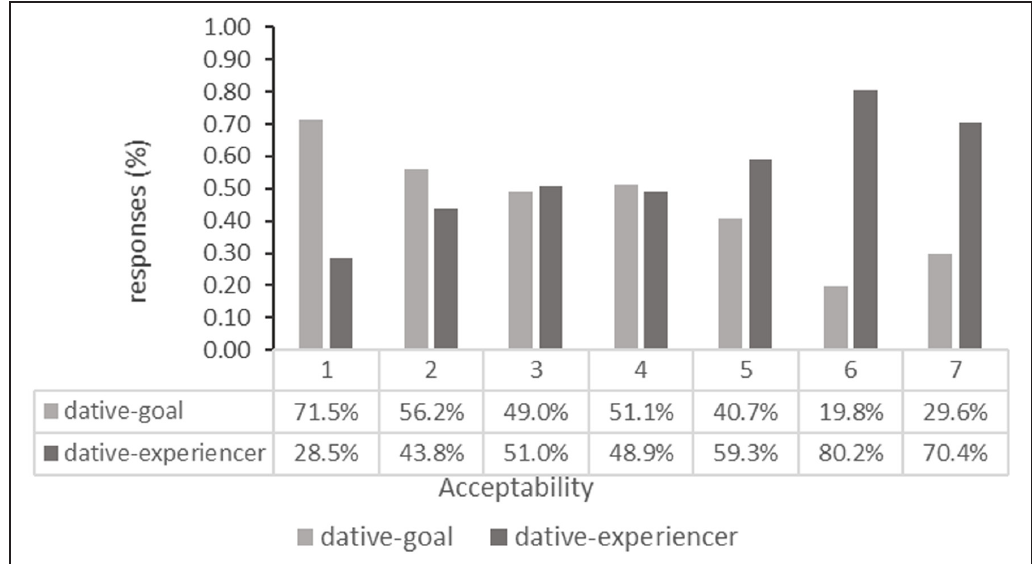
Figure 2: Distribution of acceptability ratings on a 7-point Likert scale in the Study 1 (1 = ‘not acceptable’; ‘7 = totally acceptable’).